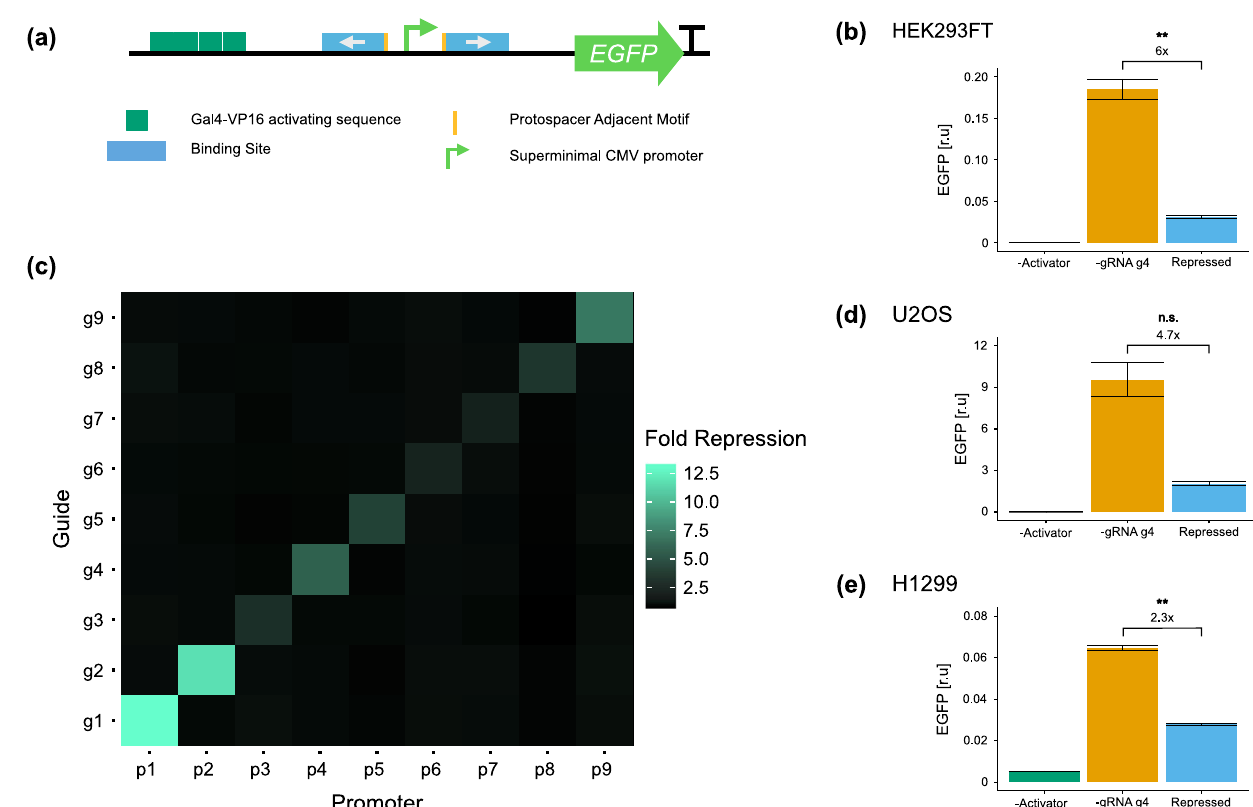
Fig. 3 Test of hdLbCas12a functionality and orthogonality in mammalian cell lines. a Design of the best-repressed promoter con fi guration. Binding sites facing opposite directions fl ank the smCMV promoter. The 5 ’ -TTTN-3 ’ PAM is proximal to either side of smCMV. b EGFP levels in HEK293FT cells in absence of activator as indication of promoter leakiness ( − Activator) or gRNA ( − gRNA g4), or upon binding of hdLbCas12a/ gRNA complex (Repressed). Data represent geometric mean and standard deviation of means of EGFP MEFL normalized by mKate expression for cells expressing >2 × 10 4 MEFL of the transfection marker mKate for at least 3 pooled replicates. c Orthogonality matrix of synthetic gRNA/ promoters. Repression levels were measured between all combinations of hdLbCas12a/gRNAs and promoters in order to determine levels of repression (with cognate pairs) and crosstalk (with non-cognate pairs). Fold repression is calculated by dividing the normalized geometric mean of EGFP MEFL of unrepressed cells ( − gRNA) by the normalized geometric mean of EGFP MEFL of repressed cells ( + gRNA), where EGFP MEFL geometric mean is normalized by mKate expression for cells expressing >2 × 10 4 MEFL of transfection marker mKate for at least 2 replicates. Of note, − gRNA samples included hdLbCas12a along with Gal4-VP16 and reporter encoding plasmids to take into account the burden imposed to the cells. d , e Test of hdLbCas12a/g4 transcription factor/promoter pair-induced repression was tested in U2OS and H1299 cell lines. Promoter output was measured in absence of activator ( − Activator), gRNA (-gRNA g4) or in presence of hdLbCas12a/g4 (Repressed). Data represent geometric mean and standard deviation of means of EGFP MEFL normalized by mKate expression for cells expressing >2 × 10 4 (H1299) or >5 × 10 3 MEFL (U2OS) MEFL of transfection marker mKate for at least 2 replicates. Statistical signi fi cance, calculated using the Student ’ s t test, is denoted by asterisks (where ** means p <